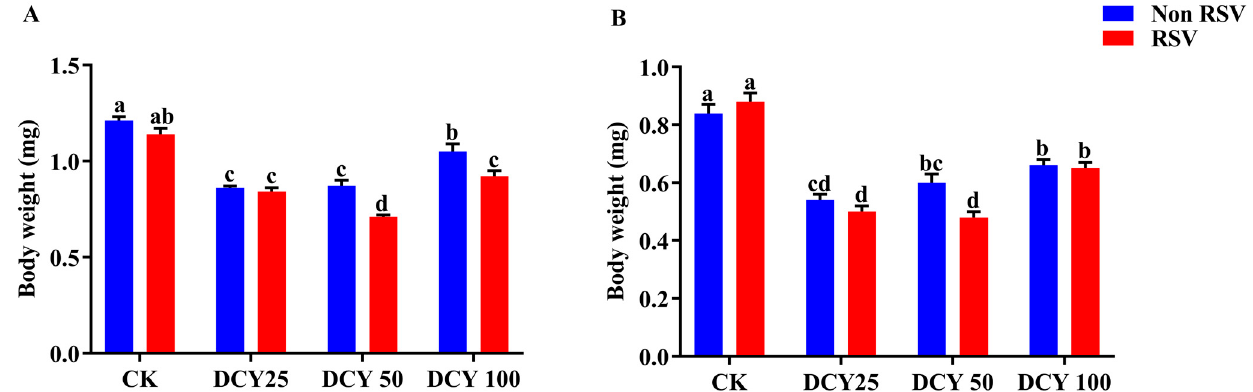
Figure 1. Body weight of different populations of SBPH on DCY-treated rice. Significant differences between treatments are indicated by different letters ( p < 0.05, Tukey’s HSD test). ( A ) Female; and